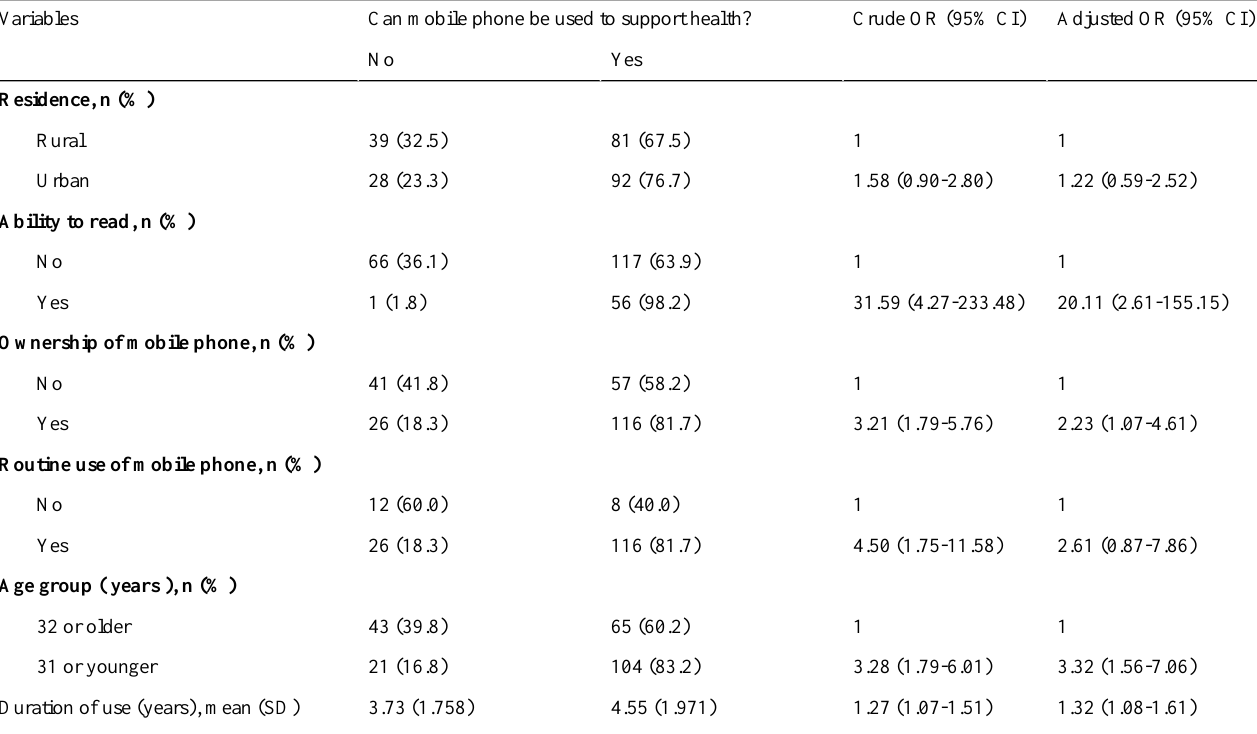
Table 4. Factors associated with perceptions about the use of mobile phones for supporting health (N=240). OR: odds ratio.